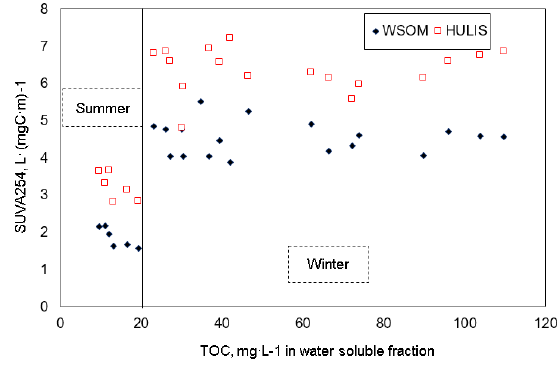
Fig. 3. Specific UV absorption at 254 nm of WSOM (filled diamond) and HULIS (open rectangle). TOC concentration referred to dissoluble organic carbon content in